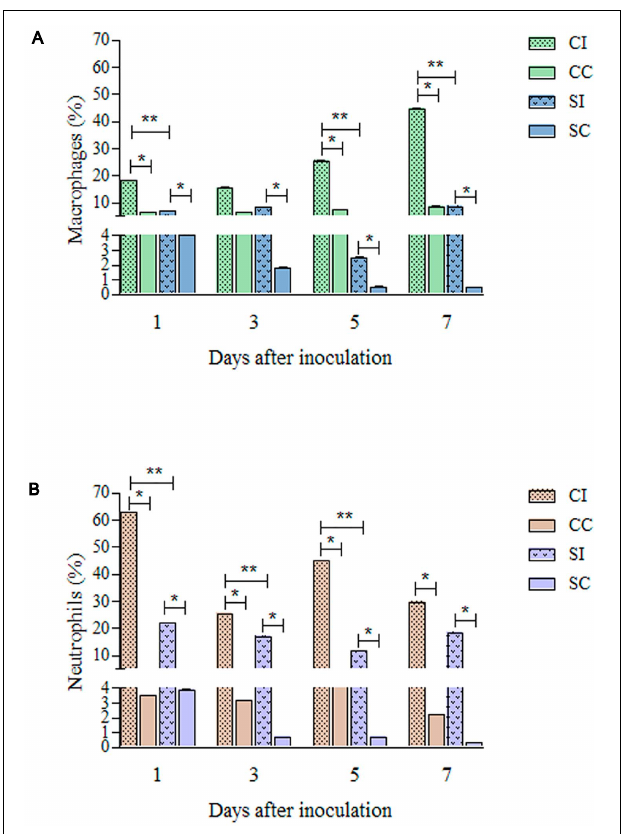
FIGURE 3 | Quantification of macrophages (A) and neutrophils (B) from skin biopsy of the tail base region of immunocompetent and immunosuppressed mice inoculated with Purpureocillium lilacinum and control groups inoculated with phosphate-buffered saline (PBS) by immunohistochemistry. CI, Immunocompetent mice inoculated with P. lilacinum ; CC, Immunocompetent mice inoculated with PBS; SI, Immunosuppressed mice inoculated with P. lilacinum ; SC, Immunosuppressed mice inoculated with PBS. *Statistical differences between infected and control groups ( p < 0.05). **Statistical differences between immunocompetent and immunosuppressed groups ( p <